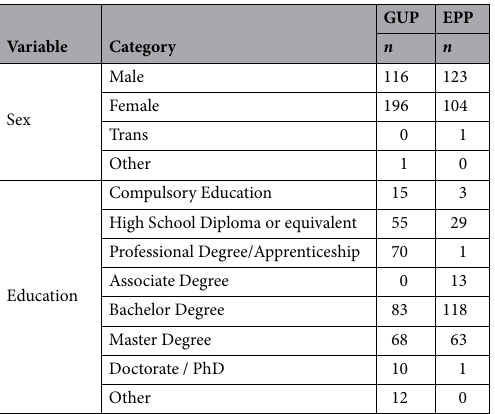
Table 6. Participant demographics. SD = standard deviation. GUP = German-speaking unpaid participants. EPP = English-speaking paid